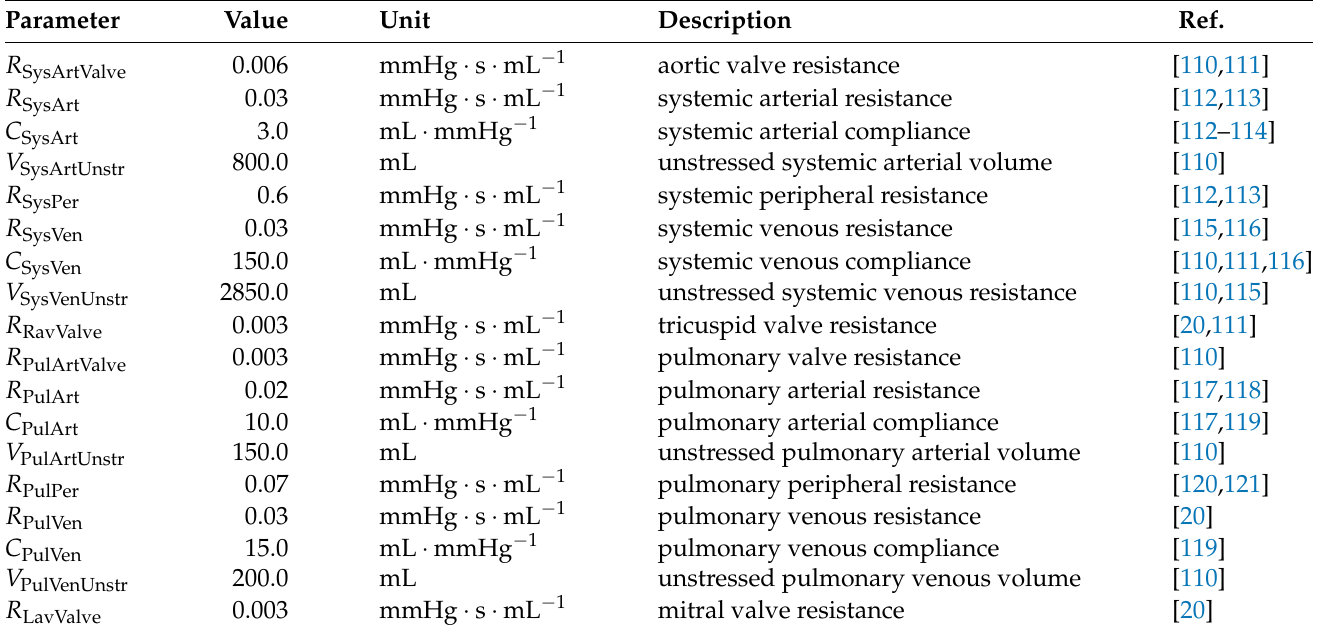
Table 4. Overview of circulatory system parameters in Section 2.2.2 for the whole heart model. Parameter